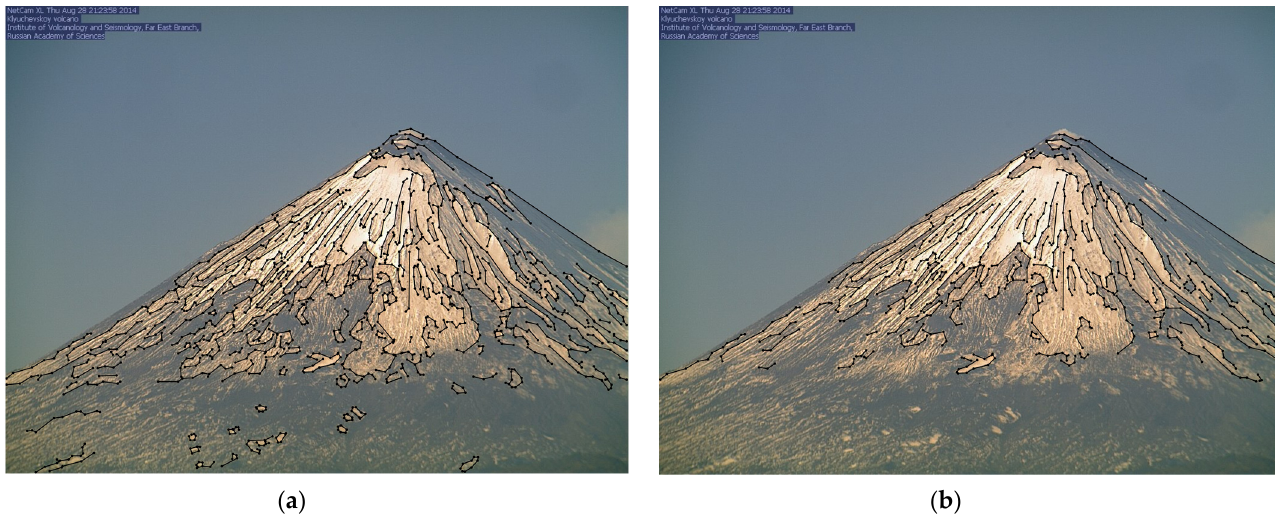
Figure 8. Examples of reference contours of Klyuchevskoy volcano, extracted for different values of γ : ( a ) γ = 0.5 —contours occurred in at least 50% of reference images; ( b ) γ = 1.0 —contours occurred in all reference images.